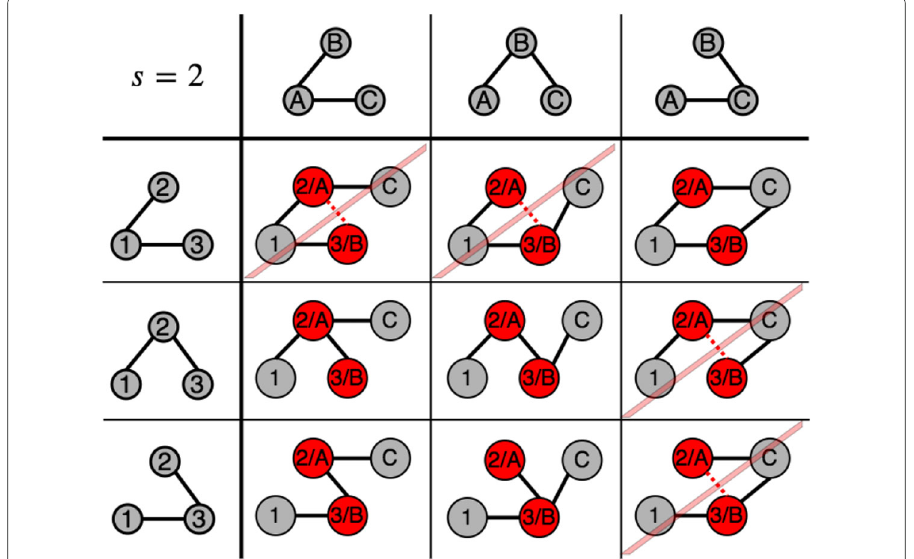
Fig. 8 Super-motifs resulting from the overlap between all NRPs of the induced 3-nodes path with s = 2 nodes. Results are shown in a matrix fashion, where the entry at row i and column j is the super-motif originating from the NRP at the i -th row and the NRP at the j -th columnn. Nodes of each super-motif contain node ids of the starting NRPs. Nodes in the overlapping region are colored in red. Red dashed lines represent edges between overlapping nodes coming from only one of the two NRPs. All super-motifs containing red dashed edges are barred, meaning that they are not returned by the overlapping operator ∩ I